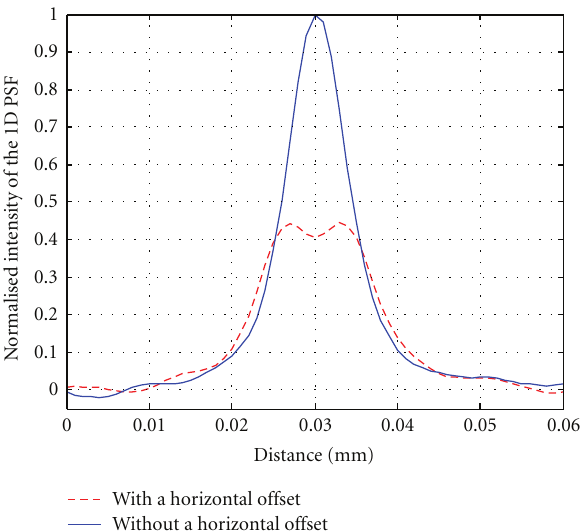
Figure 9: Radial profile of the reconstructed water phantom.